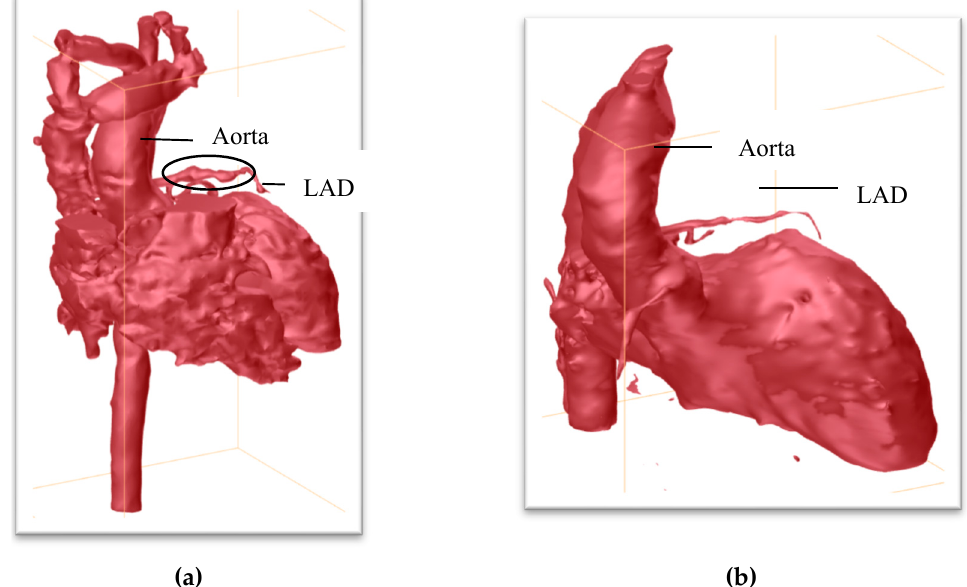
Figure 1. Comparison of initial cardiac MRI upon presentation and repeat cardiac MRI about 8 months later. ( a ) Three-dimensional cardiac MRI. This image demonstrates the aneurysm of left anterior descending coronary artery (LAD) which is classified as a giant aneurysm with a z-score of 13. The circle shows the beading of the LAD secondary to aneurysms. ( b ) Repeat MRI showing improvement of the LAD.